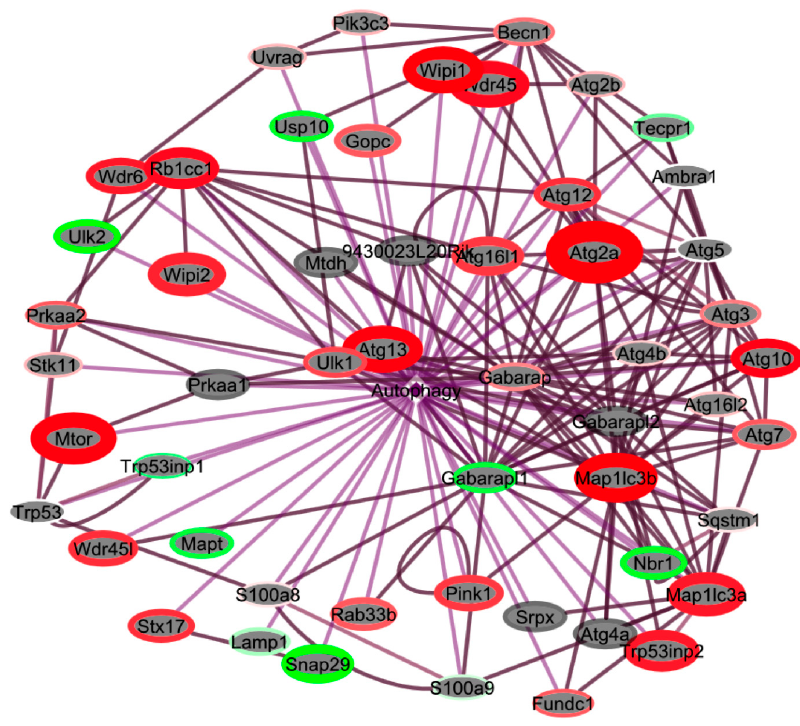
Figure 8. Autophagy programs are upregulated in livers from spaceflight mice. Cluster analysis using EGAN software was performed using genes associated with autophagy programs generated by BIOMART. Genes were clustered using a radial force-driven display. Intensity of color (red = upregulated, green = downregulated, grey = not detected) is associated with degree of fold change and width of the bounding circle is inversely related to p (corr)- value. n = 6 animals per group were used for the analysis.